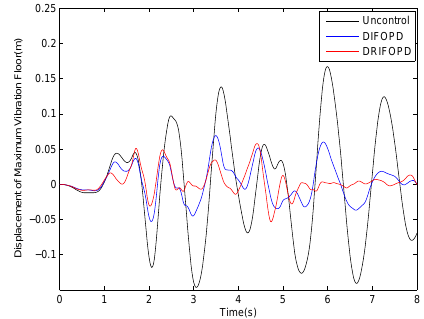
Figure 13. The displacement of the maximum vibration floor under fault case